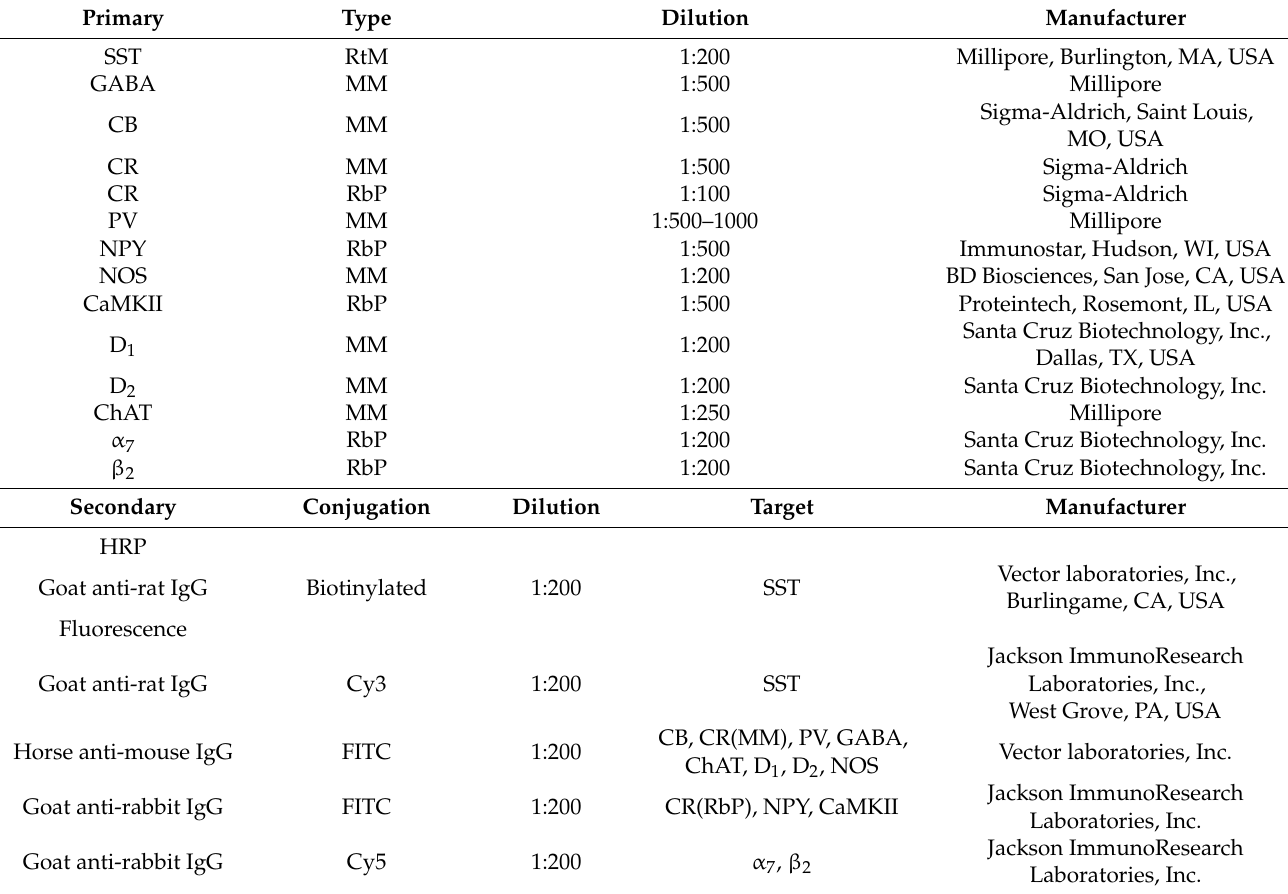
Table 1. List of primary and secondary antibodies and their dilution used in present